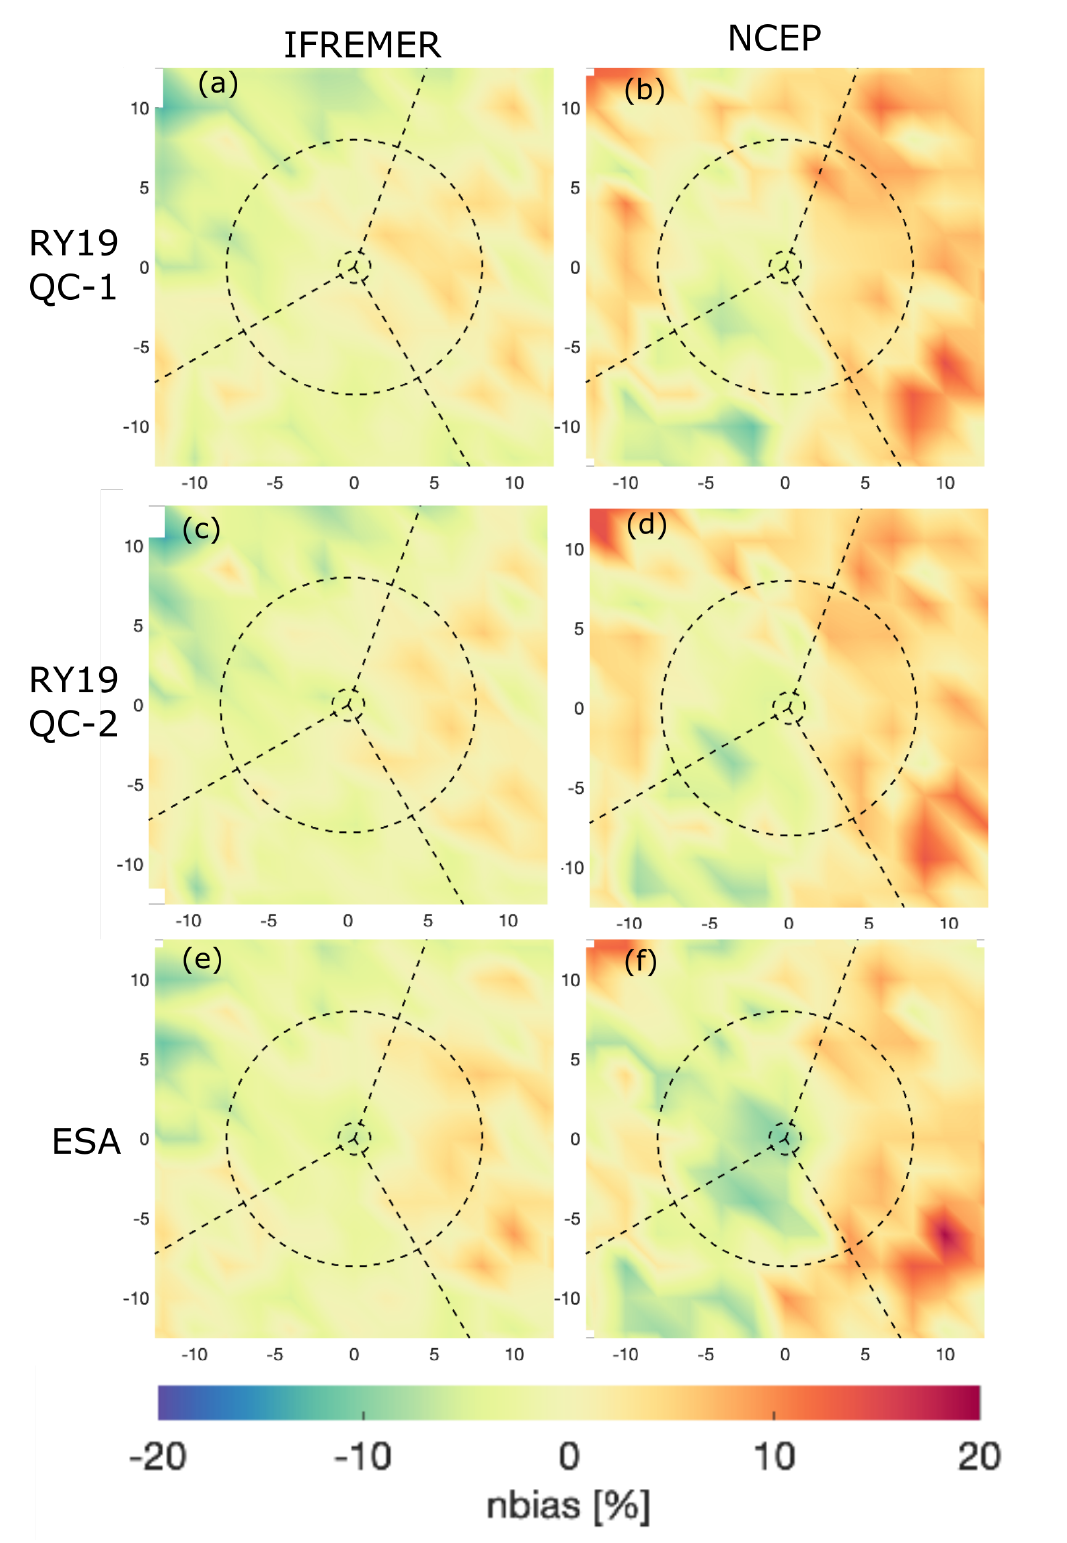
Figure A1. Normalized bias in a TC-centered frame of reference. Left column from Ifremer hindcast. Right column from NCEP hindcast. Top to bottom is RY19 QC-1, RY19 QC-2, and ESA altimeter